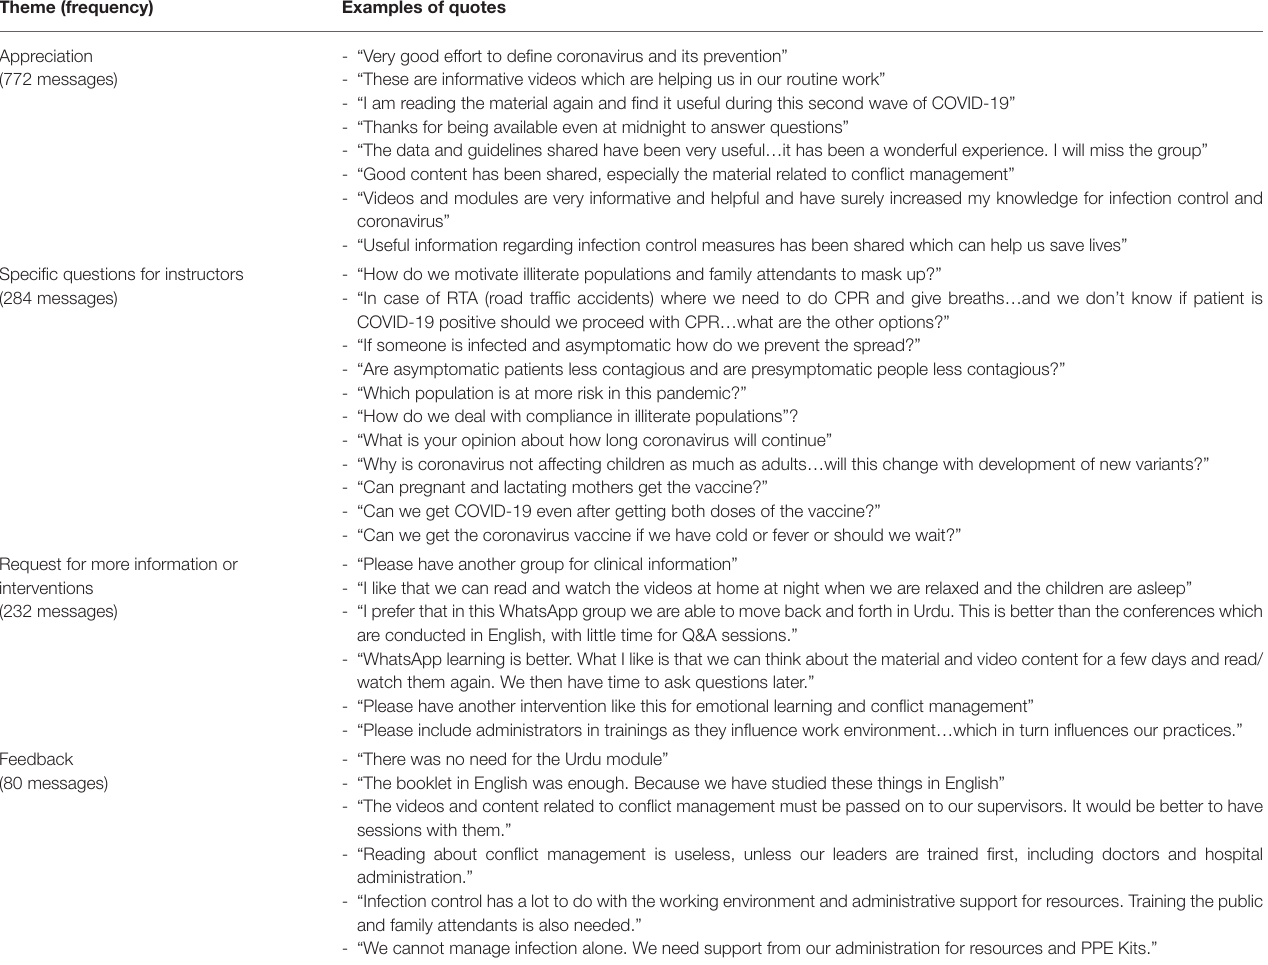
TABLE 7 | Themes from the content analysis describing intervention group participant interaction. Theme (frequency) Examples of quotes Appreciation (772